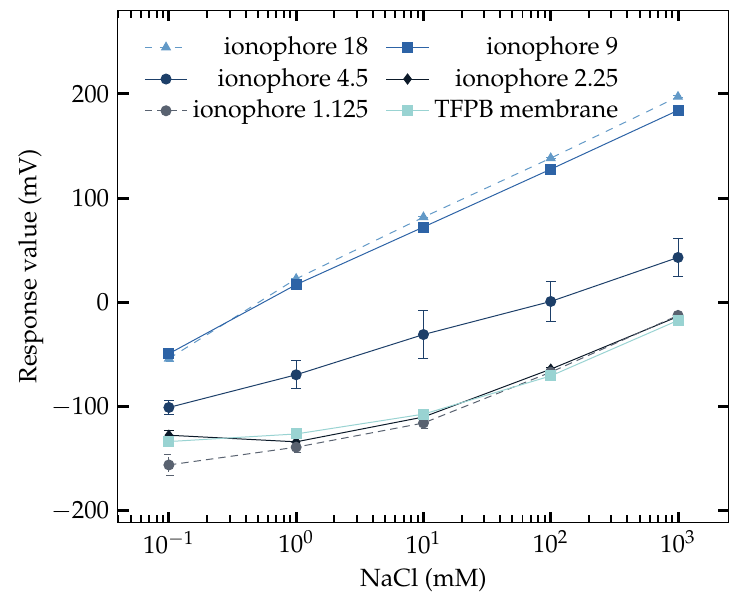
Figure 2. Responses of TFPB membrane and NaISE to NaCl solutions. The responses of NaISE are name after the amount of Na + ionophores used.